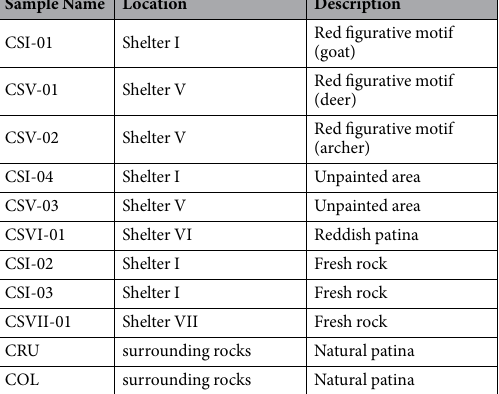
Table 1. Samples description.